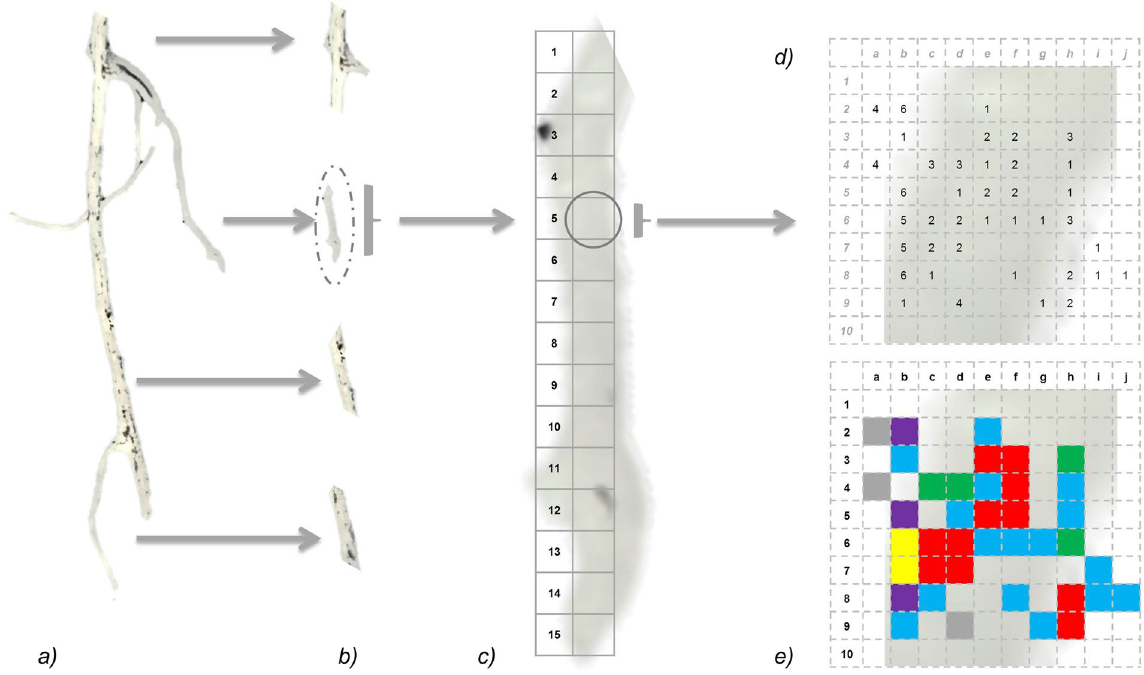
Figure 2. Schematic framework of MycoPatt model. ( a ) Root system; ( b ) selection of 1 cm segments; ( c ) segment analysis flow - 15 microscopic fields/segment; ( d ) MycoPatt grid overlay on each microscopic field with the assignment of values for mycorrhizal structures: (1) hyphae, (2) arbuscules, (3) vesicles, (4) spores, (5) auxiliary cells, (6) entry points; ( e ) conversion of values into colors for development of mycorrhizal map: (1) blue, (2) red, (3) green, (4) gray, (5) yellow, (6) purple.